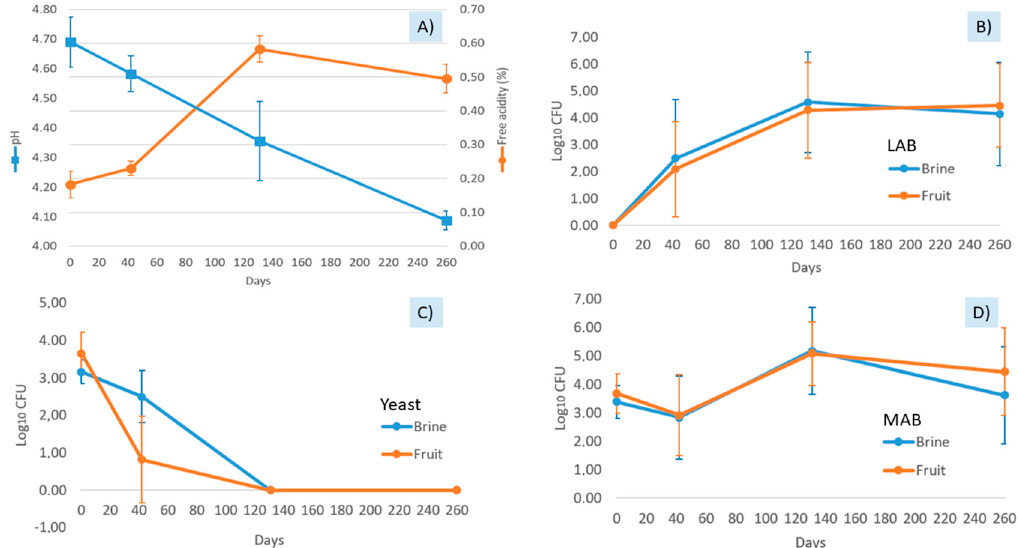
Figure 1. Evolution of physicochemical parameters ( A ) and microbial population ( B – D ) throughout the shelf-life of packed Aloreña de M á laga . LAB stands for lactic acid bacteria. MAB stands for mesophilic aerobic bacteria. In figure A, the blue line indicates the pH value, while free acidity is indicated as an orange line. For microbial counts, blue lines refer to brines samples, while fruit samples are indicated as orange lines. Means and error bars were obtained from two independent packed table olive samples analysed at each sampling time. No significant differences were obtained for the counts between brine and fruit matrix at the different sampling